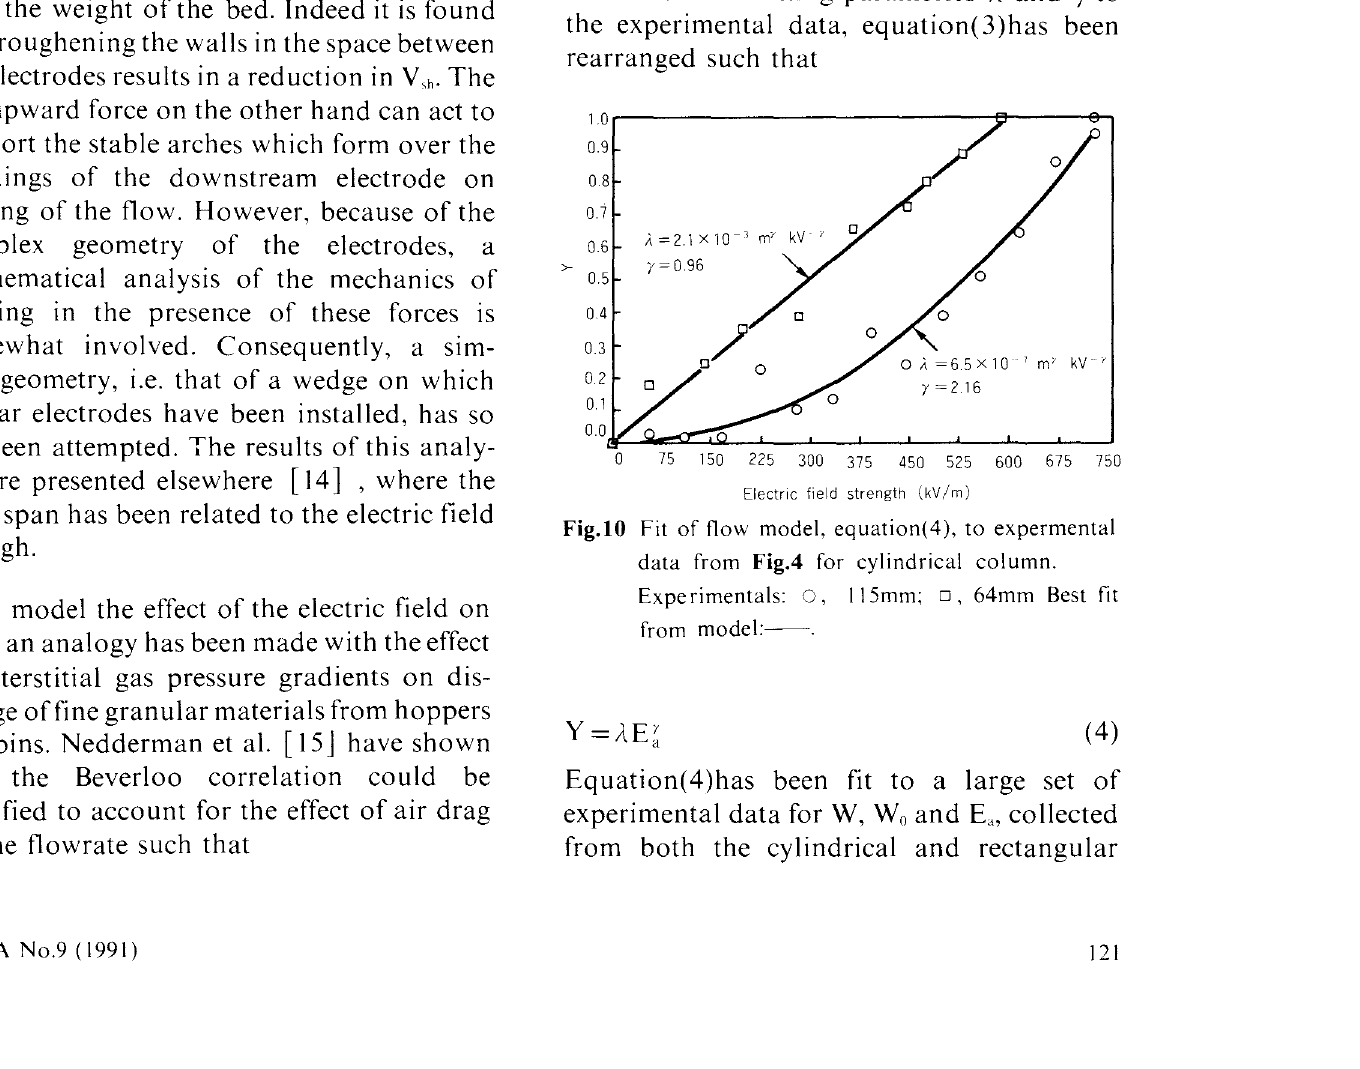
Fig.lO Fit of flow model, equation(4), to expermental data from Fig.4 for cylindrical